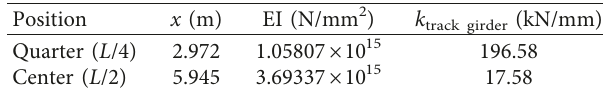
Table 3: Equivalent spring stiffness for each location on the track